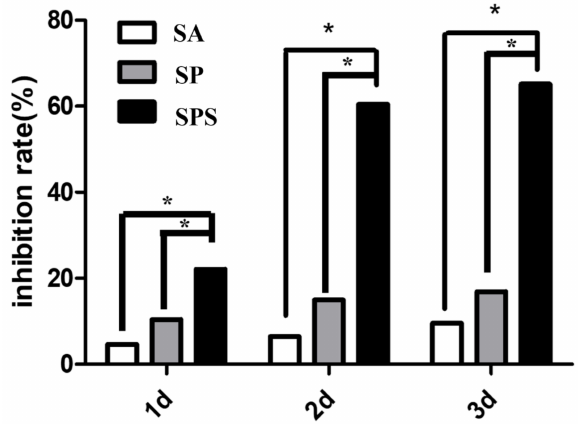
Figure 10. Inhibition rate of the SPS, SP and SA hydrogel spheres on the colon cancer cells (* p <